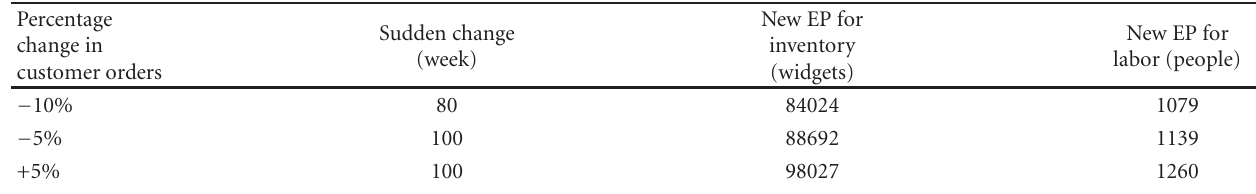
Table 4: New EPs reached after the system was perturbed.